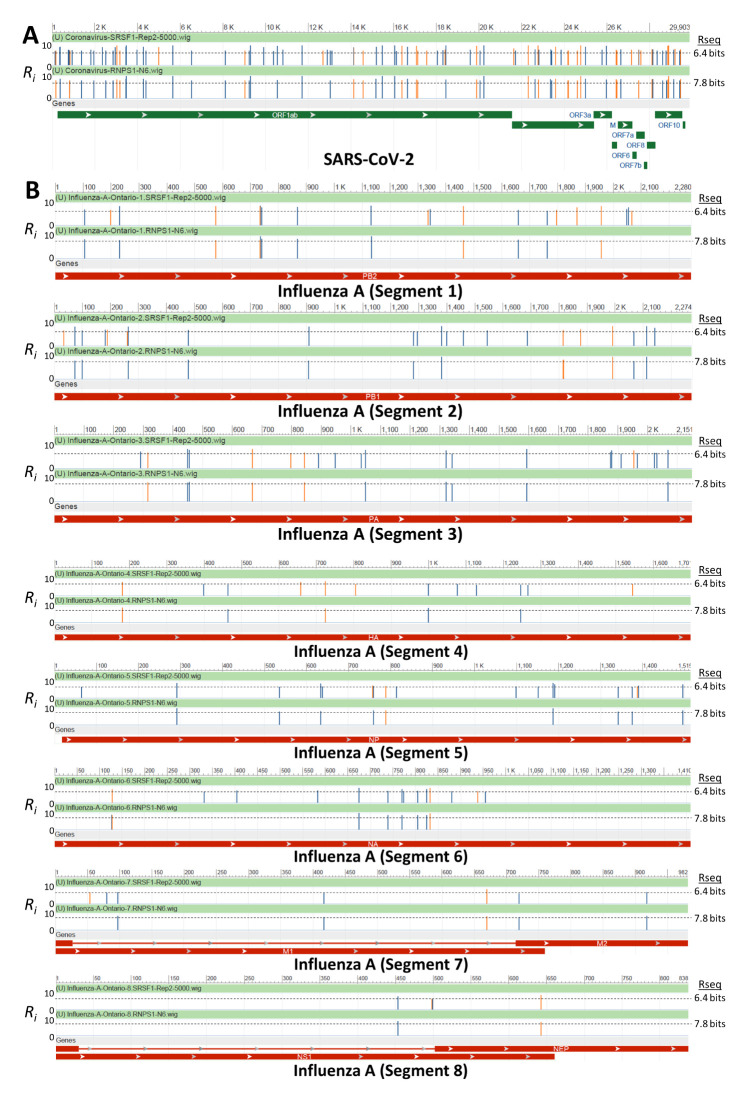
Distribution of SRSF1 and RNPS1 Binding Sites Across SARS-CoV-2 and Influenza A.The viral genomes of
A) SARS-CoV-2 (NCBI Reference Sequence: NC_045512.2) and
B) Influenza A virus (A/swine/Ontario/104-25/2012[H3N2]) were scanned for strong pre-existing binding sites for the RBP RNPS1 and SRSF1 (newly derived “Replicate 2” model). Custom wiggle tracks which contained those RBP of
R
i ≥
R
sequence were generated and visualized by NCBI Nucleotide. Track images were manually adjusted to indicate the strand in which the binding site was identified (blue vertical lines indicate sites on the positive strand, orange on the negative strand). The majority of sites predicted by the RNPS1 model were simultaneously predicted by the SRSF1 model, however the SRSF1 model identifies additional unique binding sites.